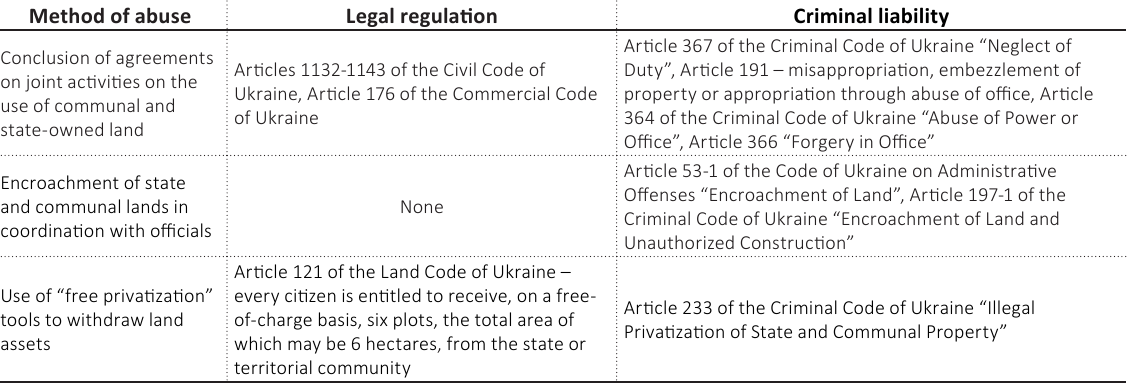
Table 1. Common methods of land encroachment in Ukraine Method of